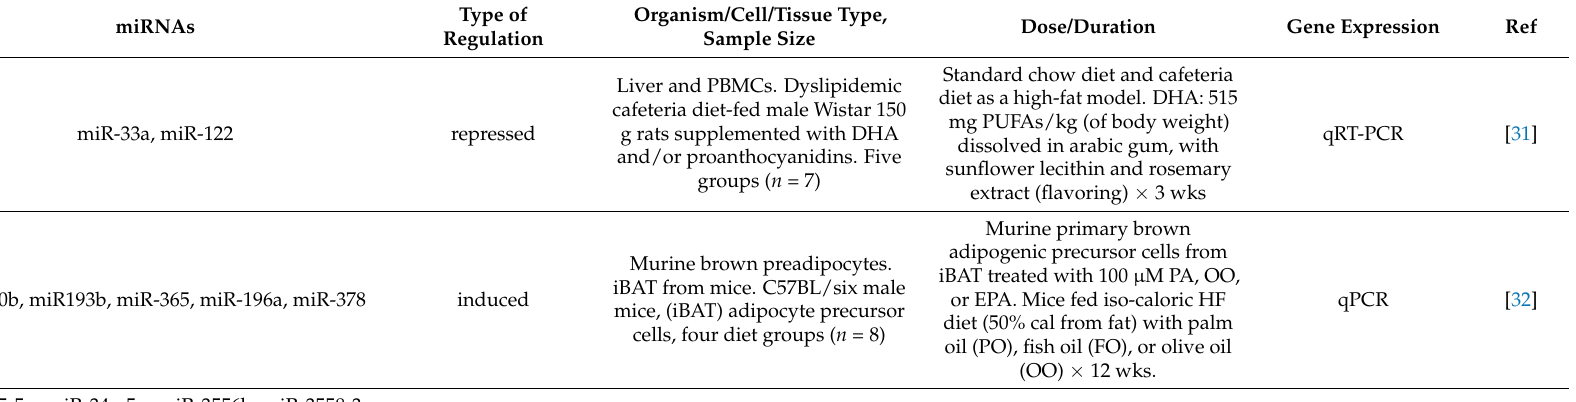
Table 1. miRNAs modulated by DFAs and their effect on metabolic